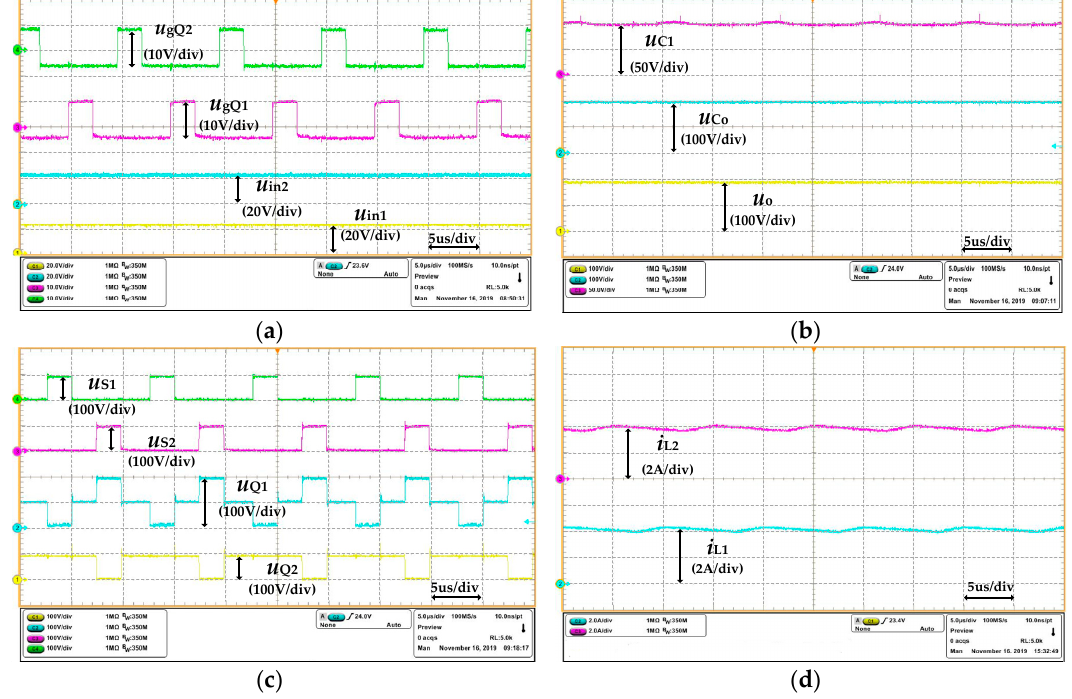
Figure 11. The waveforms of the experimental prototype. ( a ) driving waveforms of the switches and waveforms of the output voltage. ( b ) waveforms of voltages of C o , C 1 , and the waveform of the input voltage. ( c ) waveforms of voltages of the switches. ( d ) waveforms of currents of the inductors.